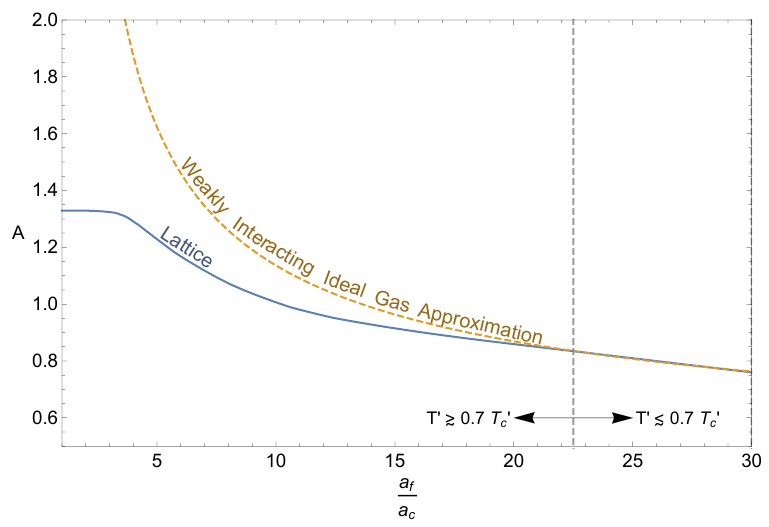
Figure 15 . The QCD 0 modi(cid:12)cation factor A as a function of a f =a c . A is de(cid:12)ned as the energy density ratio of the actual glueball gas to that derived by a non-interacting ideal gas approximation and glueball number